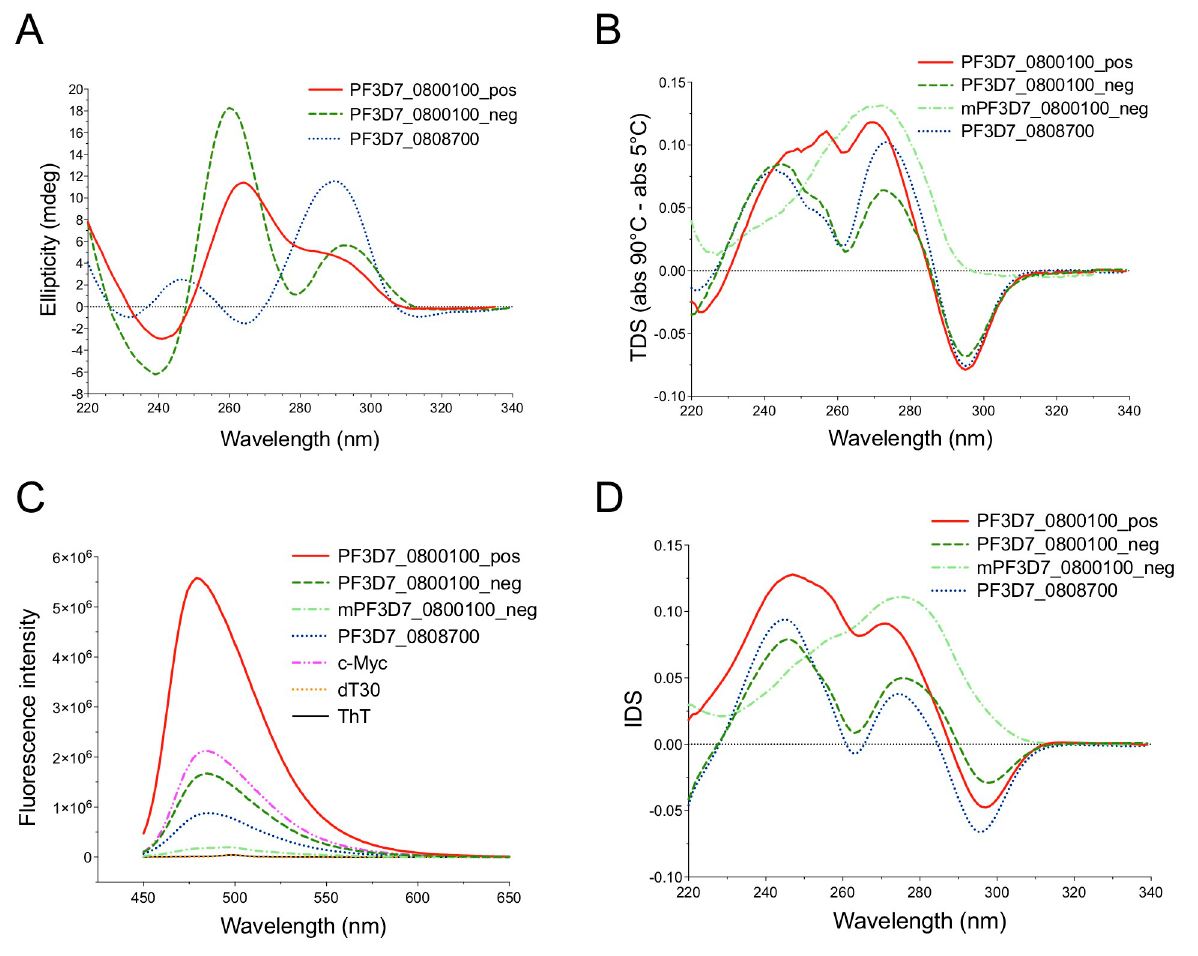
Fig 6. Biophysical characterization and transcriptional control of G4FS in var promoters. (A) Circular dichroism (CD) spectra of the three selected G4FS in var promoters. The measurements were carried out in 100 mM KCl at 6 μ M and at 5˚C, except PF3D7_0800100_pos which was folded at 3 μ M and at 20˚C. The G4 oligonucleotide sequences are presented in Table 3. (B) Thermal difference spectra (TDS) of the three G4FS and mPF3D7_0800100_neg, the mutated version of PF3D7_0800100_neg, in 100 mM KCl and at 4 μ M. (C) Fluorescence emission spectra of ThT in the presence of selected G4FS. DNA samples were prepared at 1 μ M in 100 mM KCl and incubated with 0.5 μ M ThT. The c-Myc and dT30 sequences (Table 3) were used as positive and negative controls, respectively. (D) Isothermal difference spectra (IDS) of the G4FS at 20˚C. The DNA samples were folded in 100 mM KCl at 4 μ